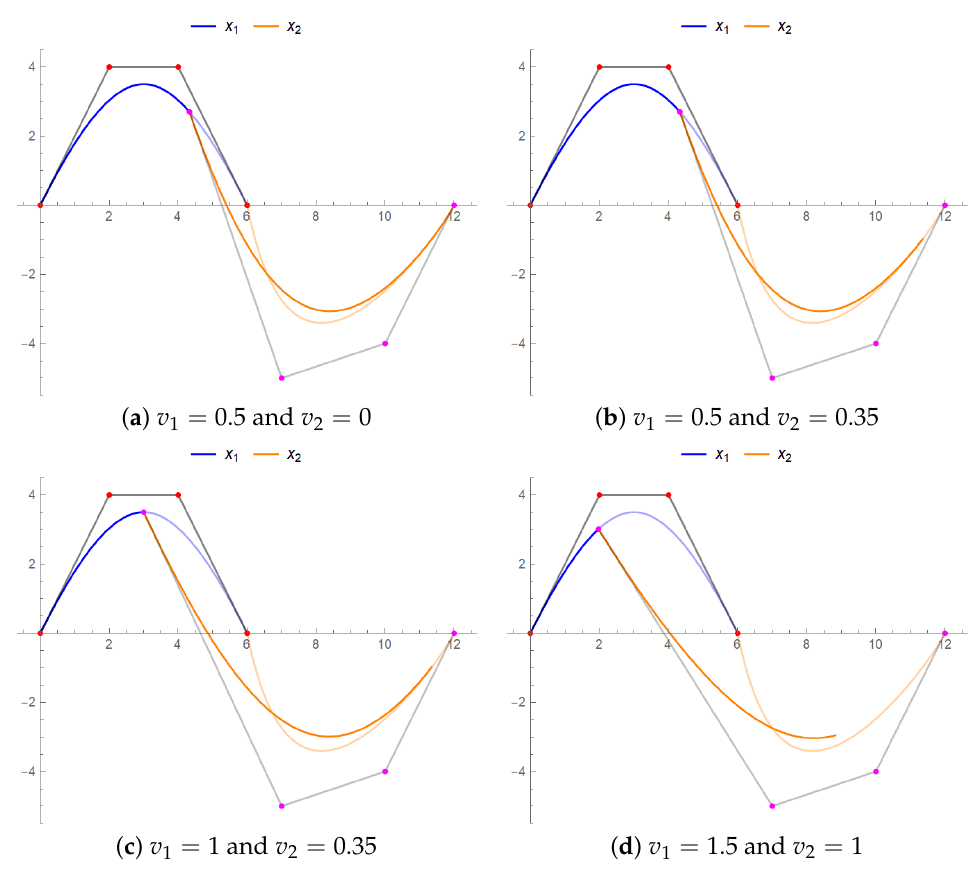
Figure 13. F 0 continuity with multiple values of v 1 and v 2